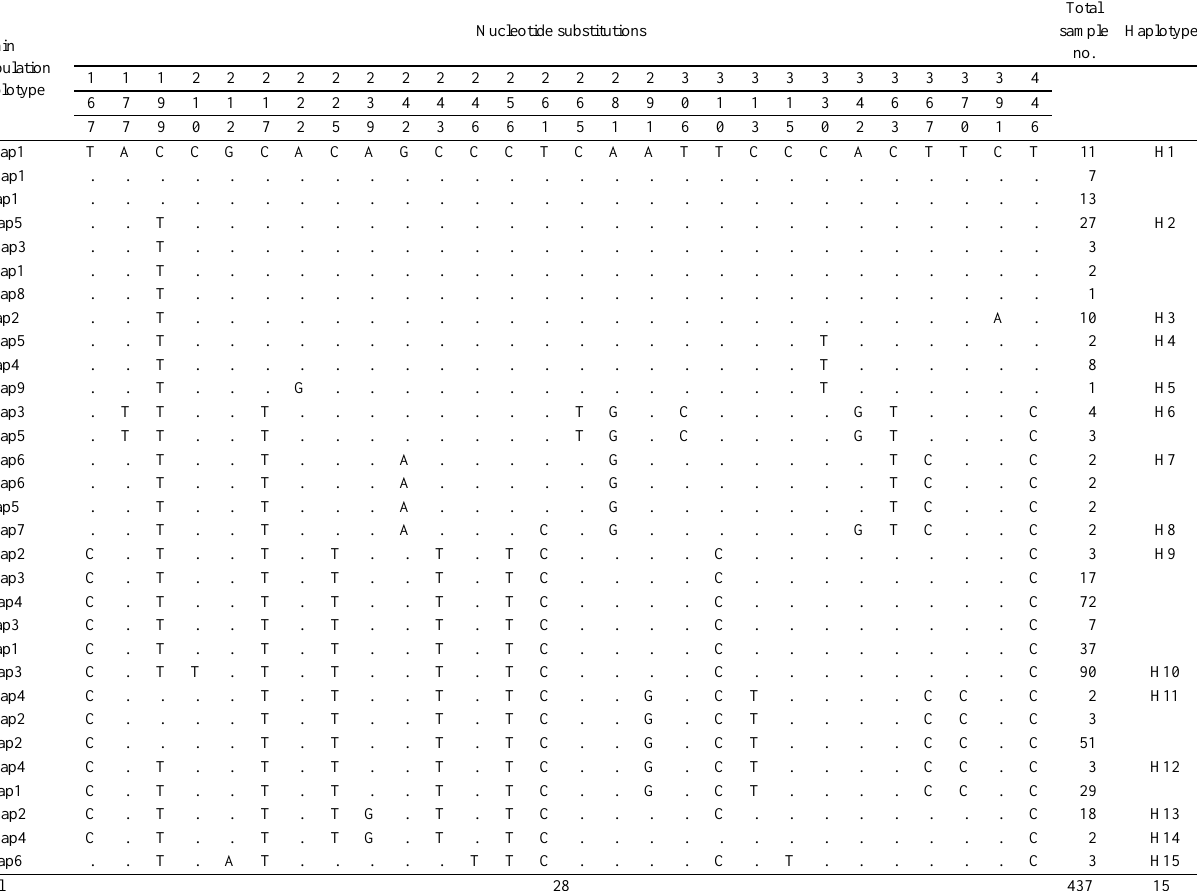
Table 3. The identified haplotypes with the mitochondrial D-loop sequence polymorphisms among the Korean native chicken populations Within population